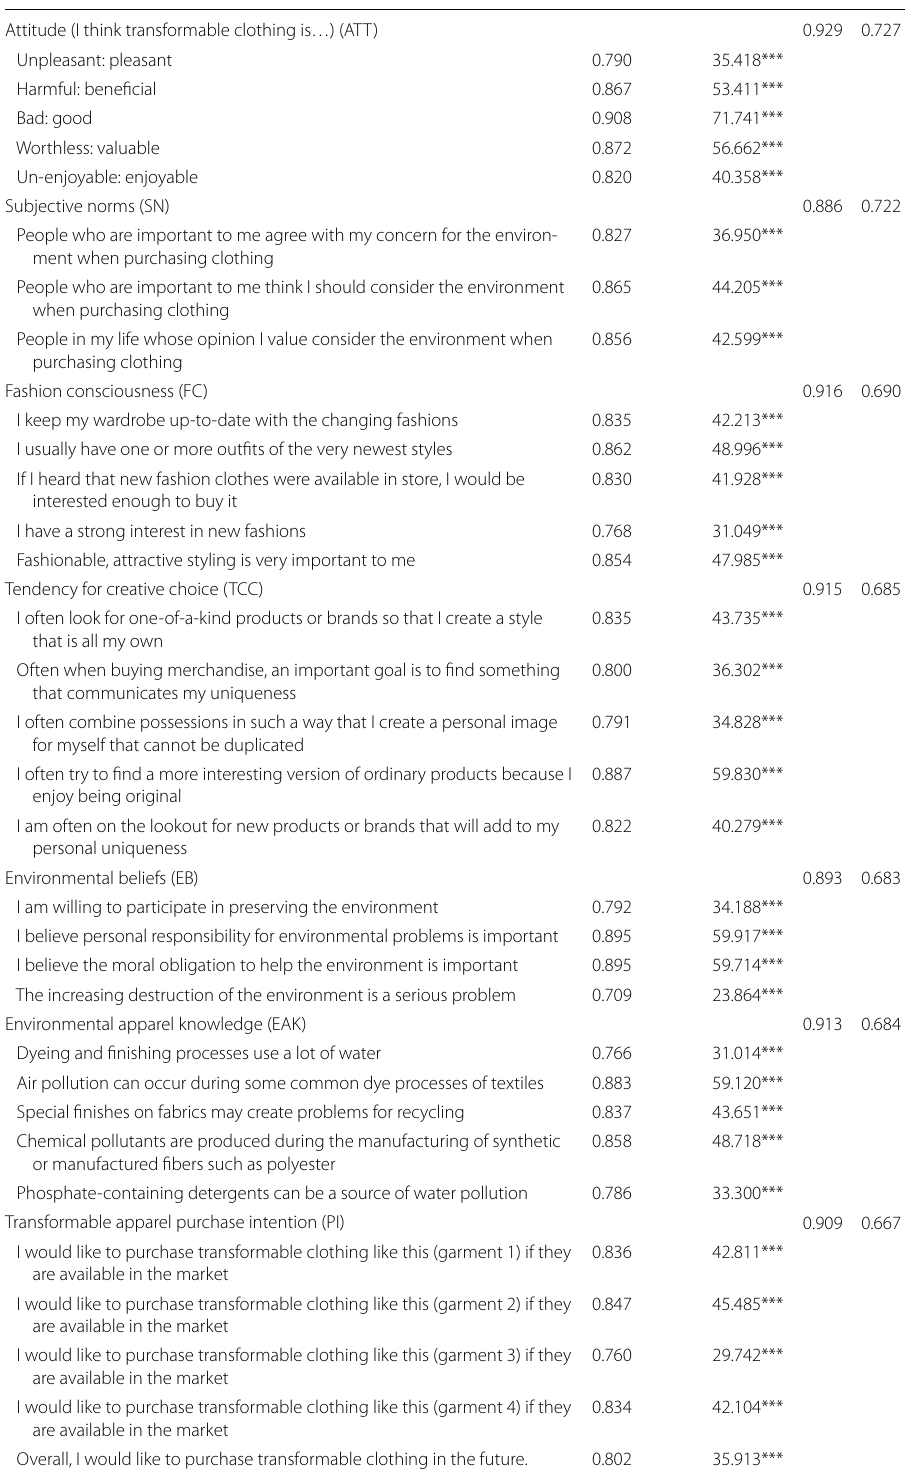
Table 1 Measurement model